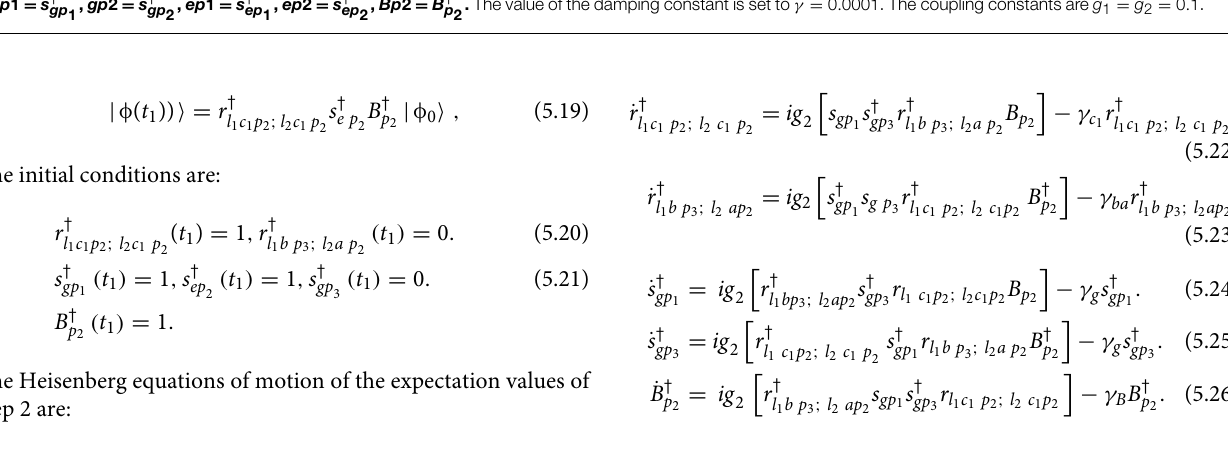
, c 1 p 2 = r † l 1 ap 1 ; l 2 bp 2 1 c 1 p 2 ; l 2 c 1 p 2